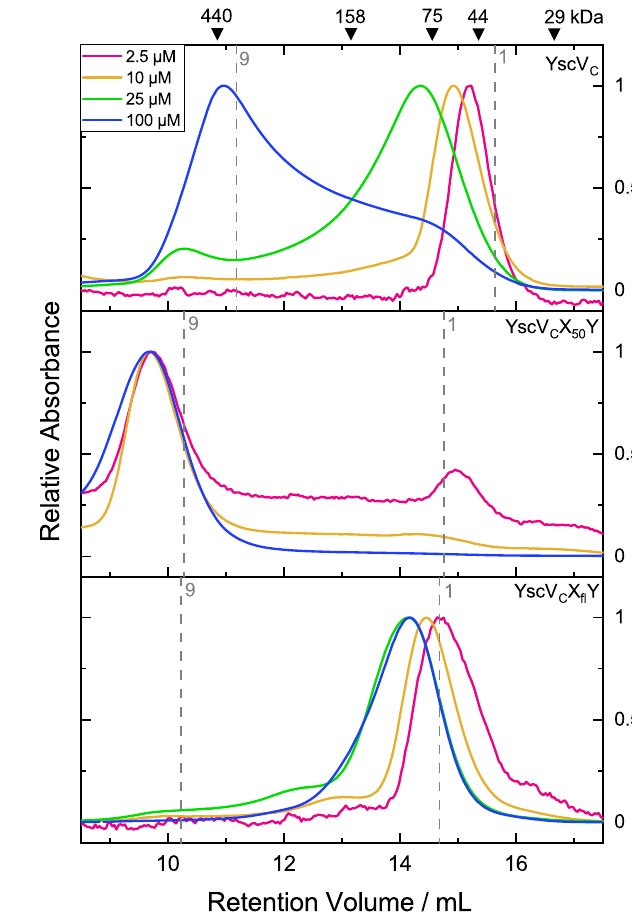
Fig. 6 Recognition of YscXY by YscV C depends on the C-terminus of YscX as well as SD3 and SD4 of YscV C . a Coomassie-stained SDS-PAGE of MBP pull-downs. N- and C-terminally truncated MBP-YscX constructs were co-expressed with His 6 -YscY and YscV C . Lysates were loaded onto amylose resin and the washed matrix loaded onto the gel. The pull-downs generated consistent results over three replications. Source data are provided as a Source Data fi le. b Analytical size exclusion chromatography with 10 µ M YscV C , YscV SD12 (both blue), YscX 32 :YscY (black), or mixtures (red) of the proteins. Absorbance at 280 nm shows a shift in retention volume for a mixture of YscV C with YscX 32 :YscY, but not YscV SD12 with YscX 32 :YscY. Chromatographies involving YscV SD12 or YscV C were performed twice or four times, respectively, with consistent results. A SDS- PAGE and Western blot analyzing contents of gel fi ltration peaks are shown in Supplementary Fig. 8.